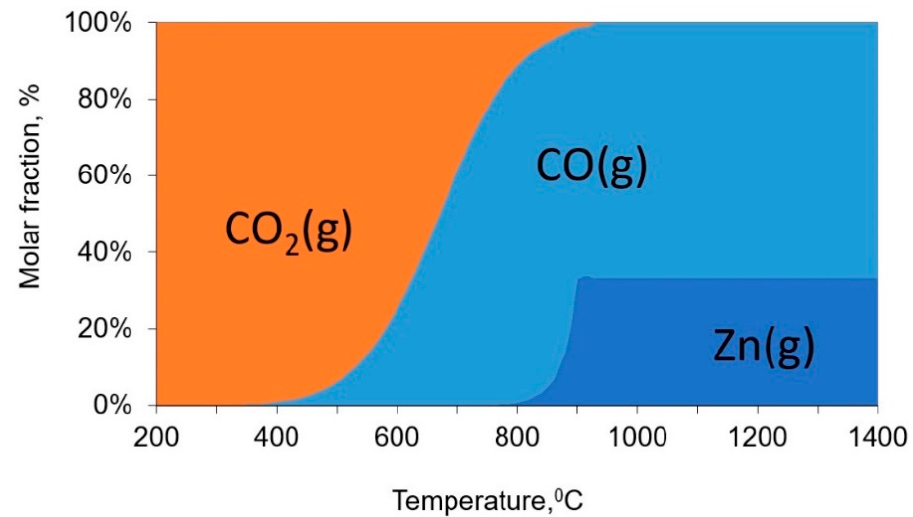
Figure 4. Equilibrium of gas phases dependent upon the temperature.